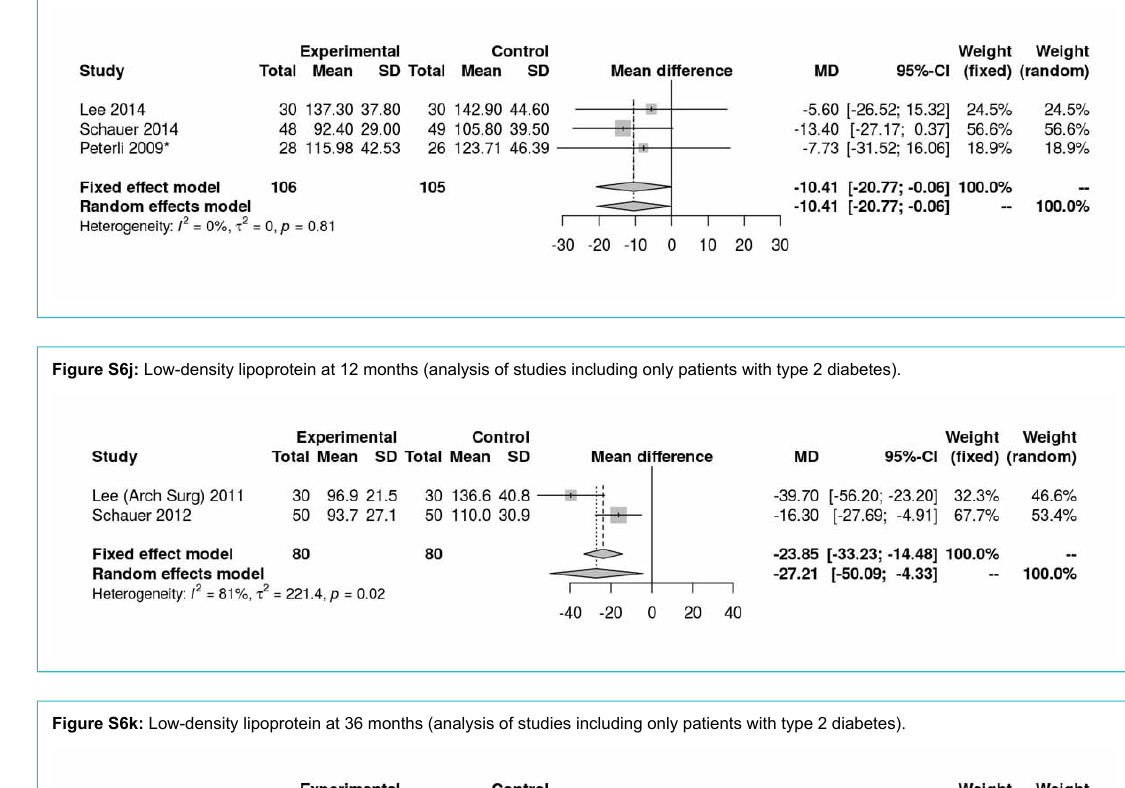
Figure S6i: Low-density lipoprotein at baseline (analysis of studies including only patients with type 2 diabetes).